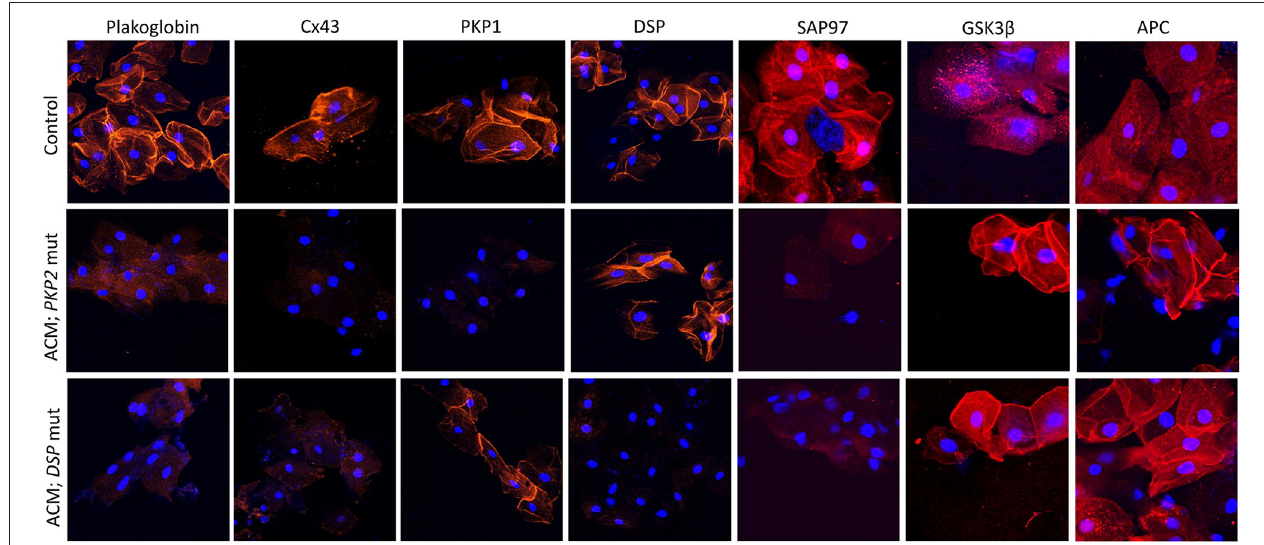
FIGURE 3 | Protein re-distribution in buccal mucosa cells from ACM patients. Representative confocal immunofluorescence images showing loss of PG, Cx43 and SAP97 membrane signal in buccal cells from ACM patients bearing a mutation in PKP2 or DSP compared to control subjects. Conversely, signal for GSK3 β and APC shifts from cytosolic to junctional pools. The patient bearing a mutation in PKP2 shows loss of PKP1 signal but not DSP while the patient bearing a mutation in DSP shows loss of DSP signal but not PKP1. Immunoreactive signal of PG, Cx43, PKP1, DSP, SAP97, GSK3 β and APC in red; nuclei were counterstained with DAPI in